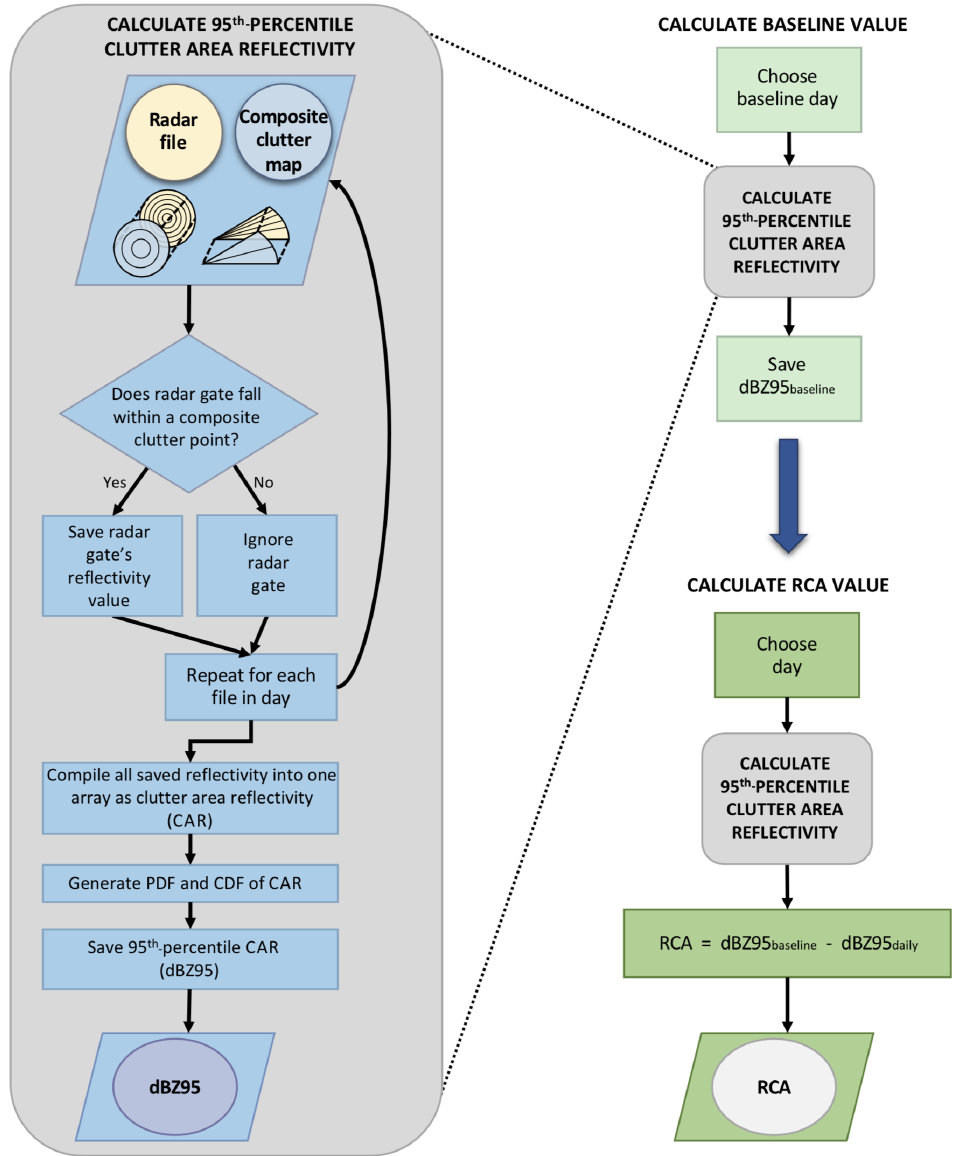
Figure 7. Workflow for calculating a baseline value from the composite clutter map and radar files. The second diagram shows how the baseline value can be used to calculate a daily adjustment to